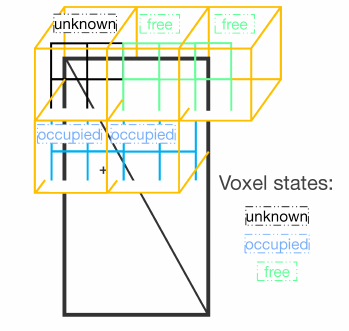
Figure 3. Usage of the voxel grid introduced in Figure 1. After the visibility check one of three states is assigned to each voxel cell. Subsequently each raster cell of the triangle receives the state of the voxel grid cell at the position of its center point.